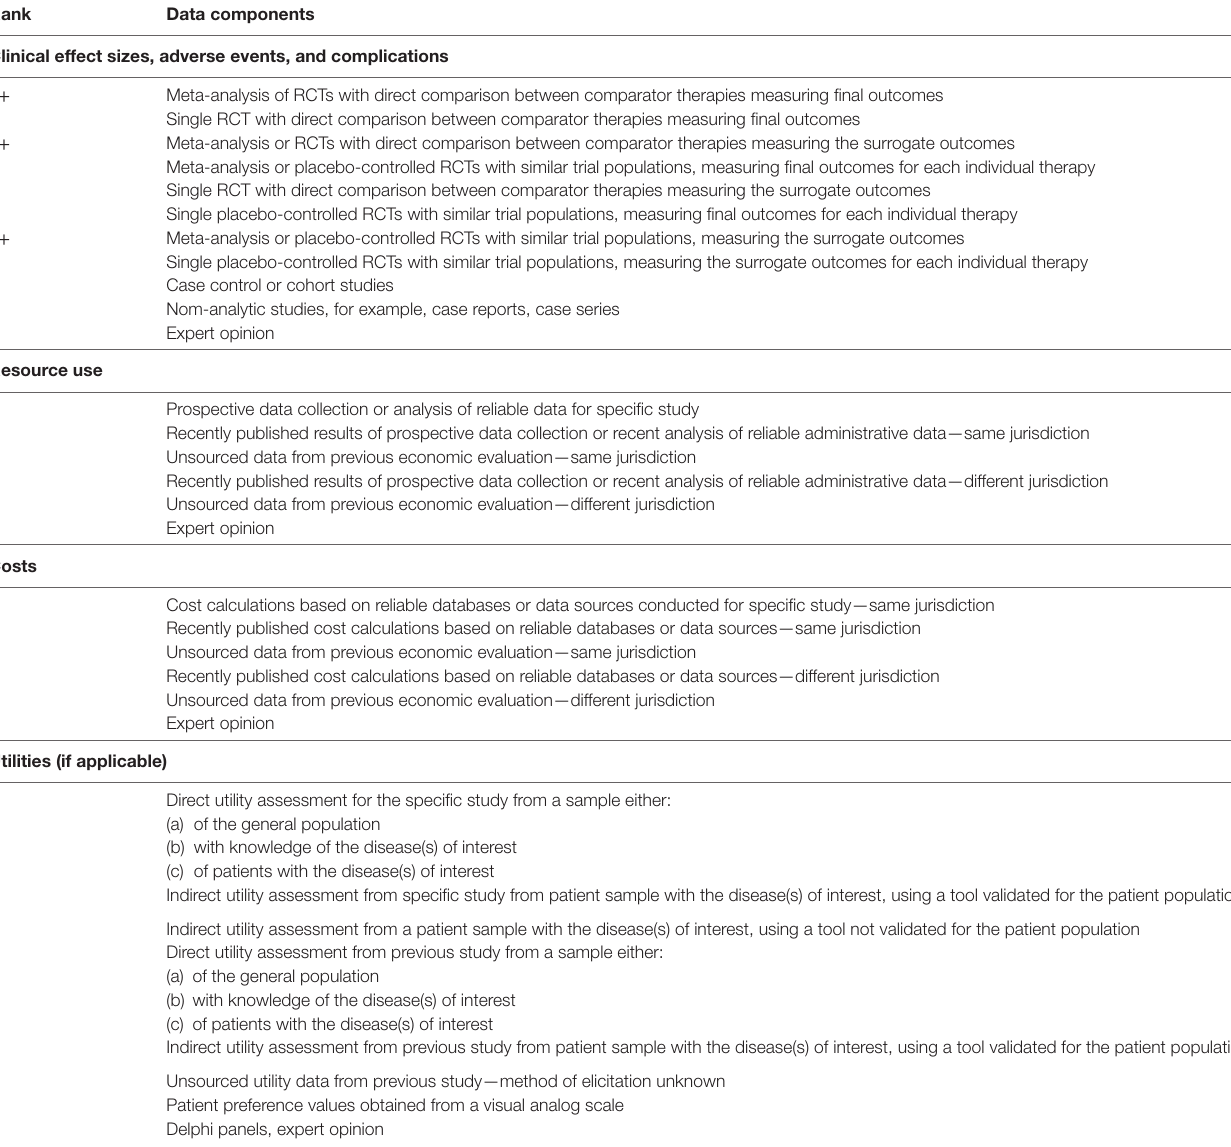
taBLe 1 | Hierarchies of data sources for health economic evaluation studies modified from Coyle and Lee (37–39). Rank Data